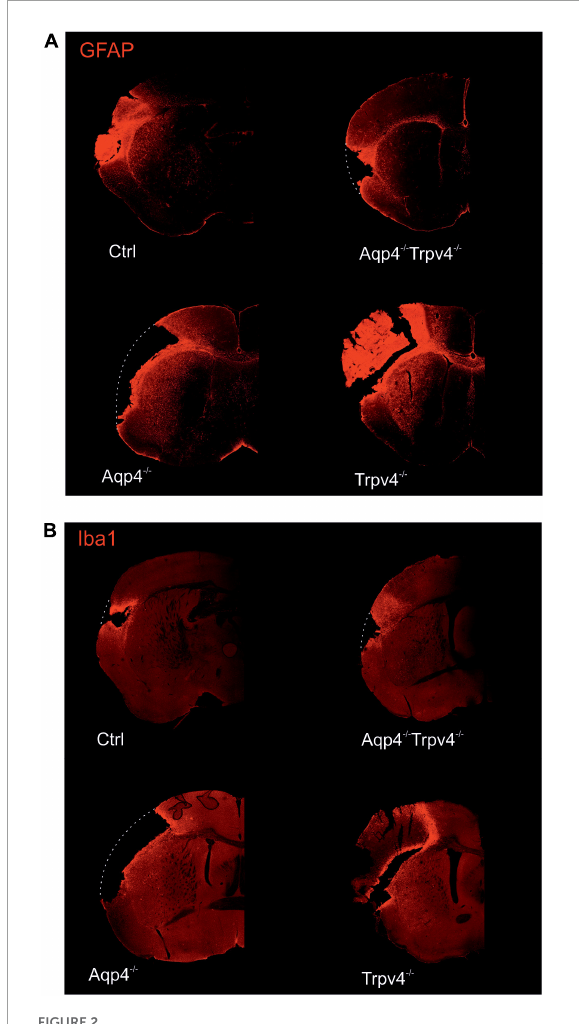
FIGURE2 Immunohistochemical staining of the brains 7 days (D7) after pMCAO. Staining with antibodies against GFAP (A) and Iba1 (B) showed that the extent of the damage in Aqp4 − / − /Trpv4 − / − mice is comparable to the Ctrl. Conversely, significantly greater damage was observed in the Aqp4 − / − /or Trpv4 − / − compared to the Ctrl and the Aqp4 − / − /Trpv4 − / − mice. The white dotted lines show the original size of the tissue slices in the places, where due to the extent of the ischemic damage some parts of the slices fell out. Details of the pictures showing GFAP or Iba1 expression are shown at right in white frames. Ctrl, control; AQP4 − / − , AQP4-deficient mice; TRPV4 − / − , TRPV4-deficient mice; AQP4 − / − /TRPV4 − / − , AQP4- and TRPV4-deficient